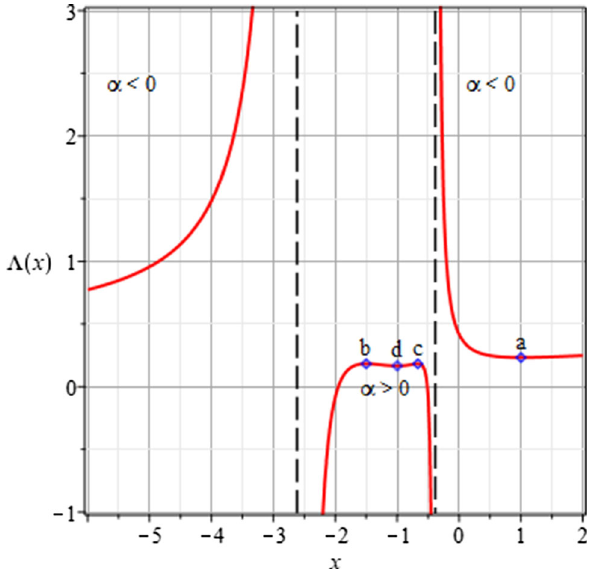
Fig. 3 The functions (cid:3)( x ) = λ( x )/α for α = ± 1 and m = l = 4